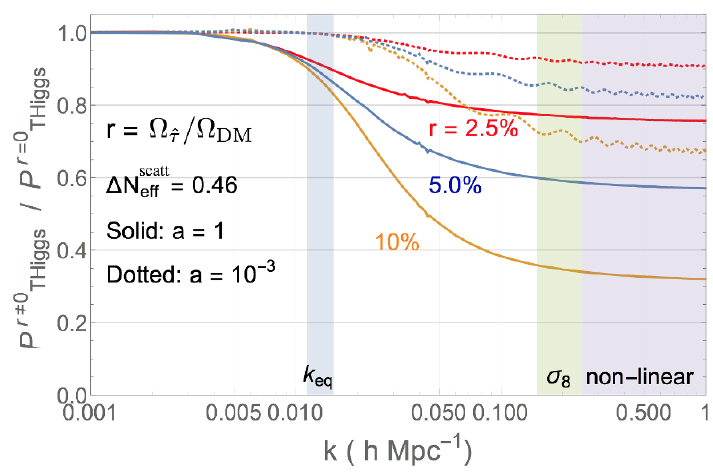
Figure 3 . Ratio of the dark matter power spectrum between the r 6 = 0 and r = 0 cases, both with N scatt